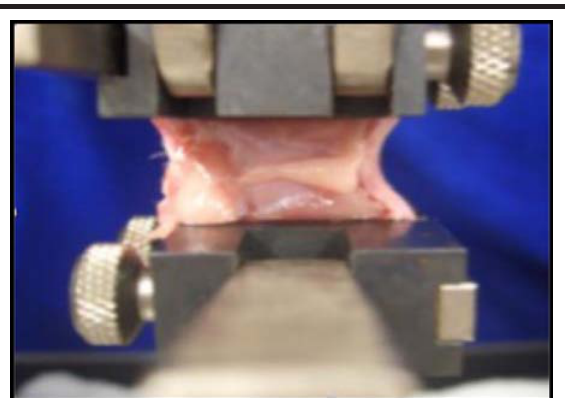
FIGURE 7 - Fixation of tissue fragment in traction machine.